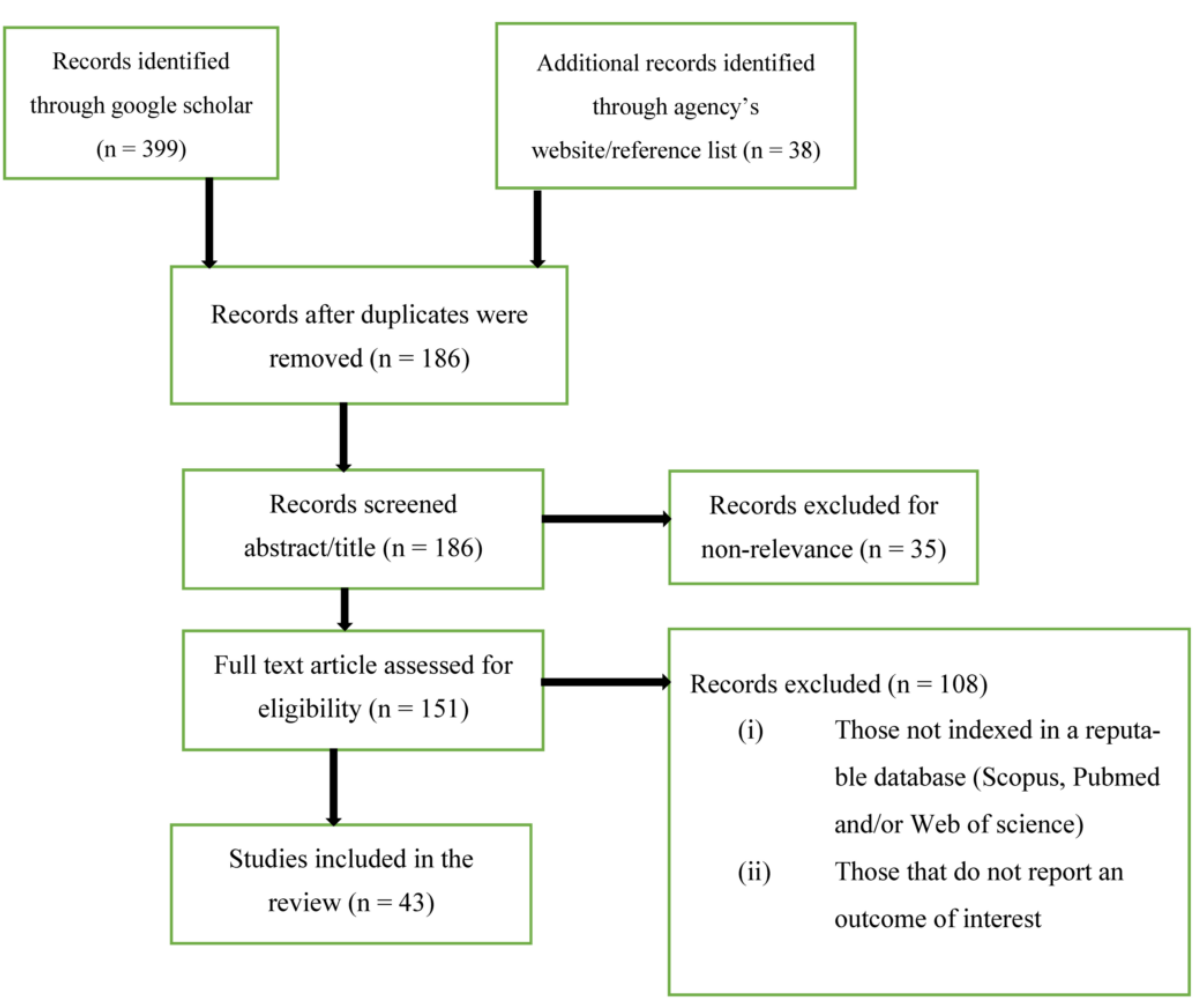
Figure 1. PRISMA flowchart for record screening/selection.